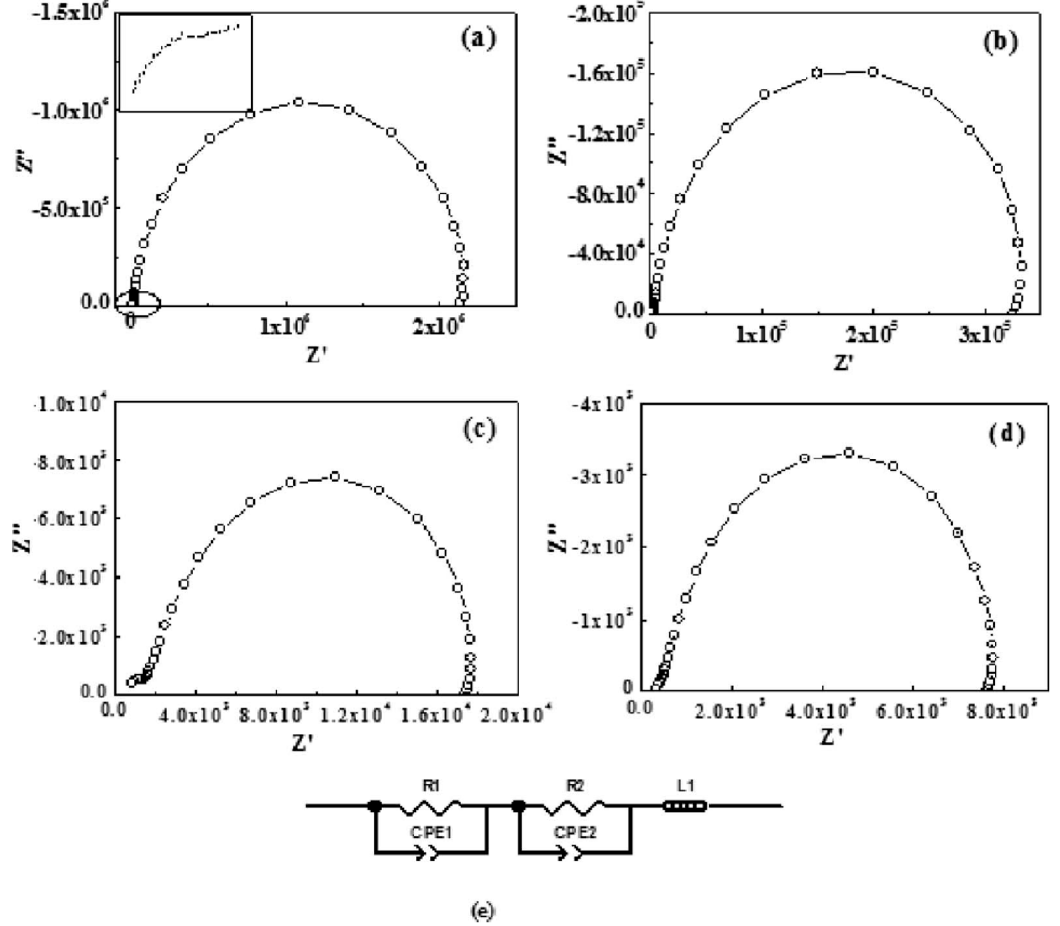
Figure 9. Impedance spectra of the MWCNT / RT-SR composites at f MWCNT = ( a ) 0.019, ( b ) 0.026, ( c ) 0.029, and ( d ) 0.032. ( e ) Equivalent circuits of the MWCNT / RT-SR composites [64].